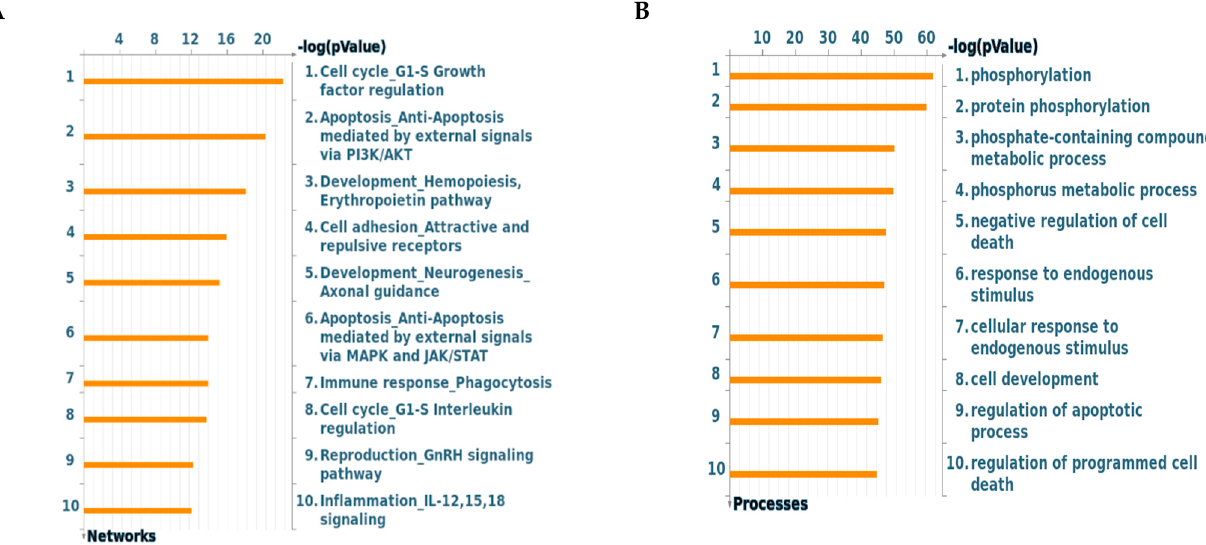
Figure 3. ( A ) The highest-ranking networks in the Saudi CRC samples (Supplementary material S1: process network). ( B ) Gene ontology (GO) processes of the Saudi CRC samples, sorted by statistically significant processes (Supplementary material S1: GO processes).